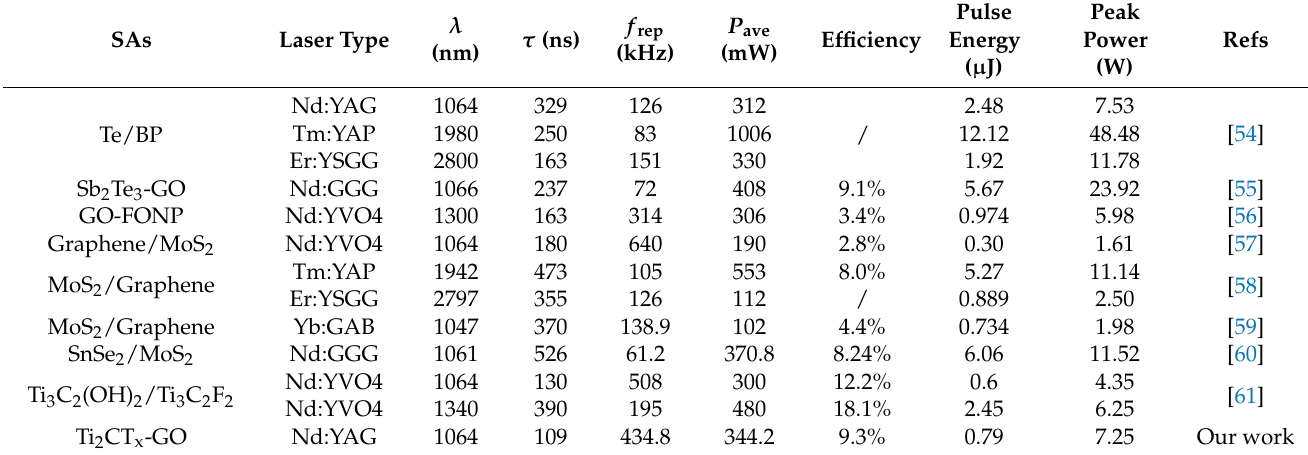
λ , central wavelength; τ , pulse width; f rep , repetition rate; P ave , average output power; efficiency, optical-optical conversion